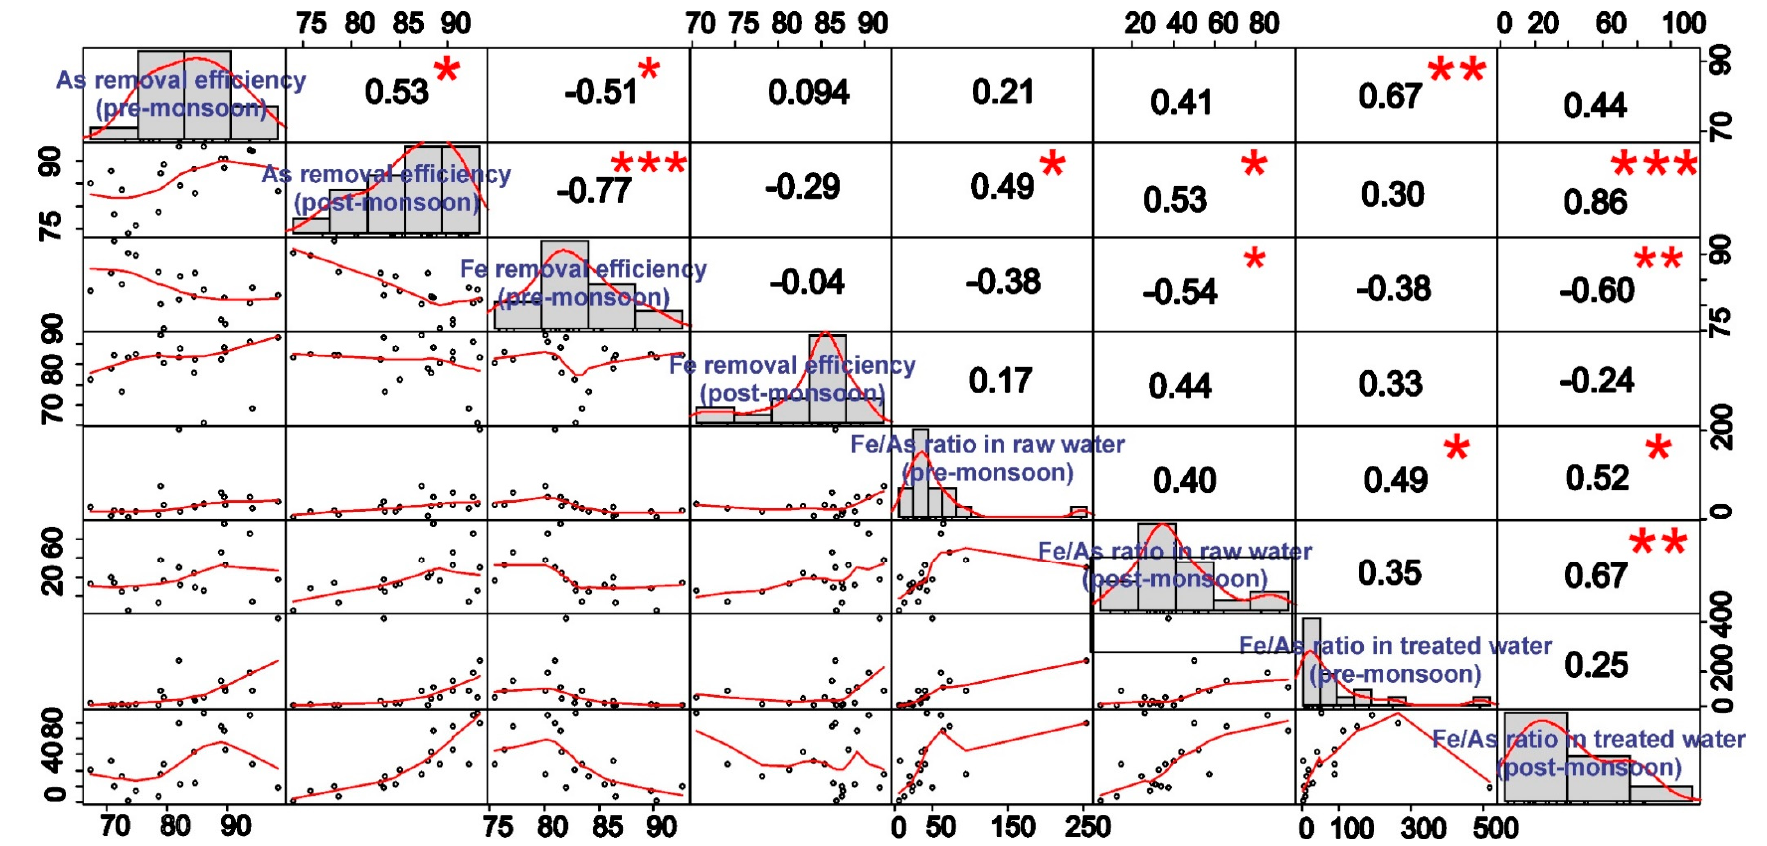
Figure 5. Pearson’s correlation analysis (* correlation is significant at the 0.05 level; ** correlation is significant at the 0.01 level; *** correlation is significant at the 0.001 level).